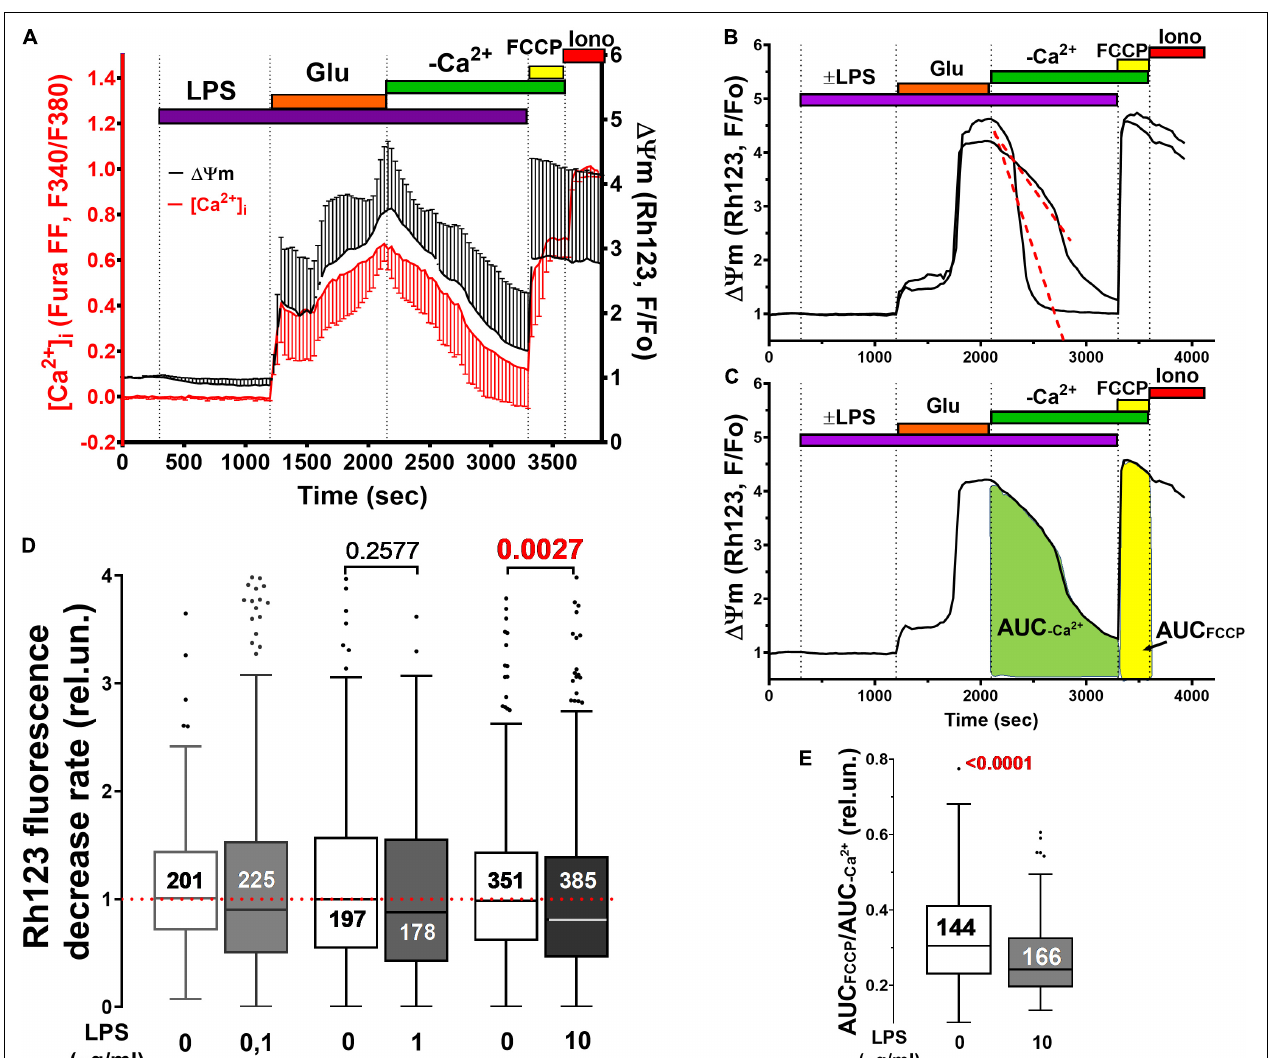
FIGURE 3 | Mitochondrial potential ( (cid:49)(cid:57) m) changes induced by Glu alone and in the presence of LPS in cultured rat brain cortical neurons. (A) Synchronous changes in (cid:49)(cid:57) m and [Ca 2 + ] i measured with a potential sensitive probe Rh123 and calcium indicator Fura-FF, respectively. [Ca 2 + ] i changes are presented as ratio F340/F380 (see legend to Figure 1 ). Changes in Rh123 fluorescence (excitation: 485 nm; emission: 525 nm) are presented as the ratio F/Fo, where F is the current fluorescence intensity, and Fo is its value at the beginning of the experiment. Curves present Mean ± SD signals of 56 individual neurons. (B,C) Illustrate the methods for quantifying (cid:49)(cid:57) m recovery during the post-glutamate period. (D) The rate of (cid:49)(cid:57) m recovery was defined as the slope of the decrease in Rh123 fluorescence following Glu washout (see panel B ). (E) Degree of (cid:49)(cid:57) m recovery in each neuron was determined as the ratio of the area under the curve of Rh123 fluorescence (AUC, rel.un.) observed during protonophore FCCP application to the AUC in the post-glutamate period (AUC FCCP /AUC − Ca 2 + ). Numbers on histogram bars indicate the amount of neurons with DCD. Statistically significant differences were determined according to the Mann-Whitney test. Data represent as Turkey box-plot